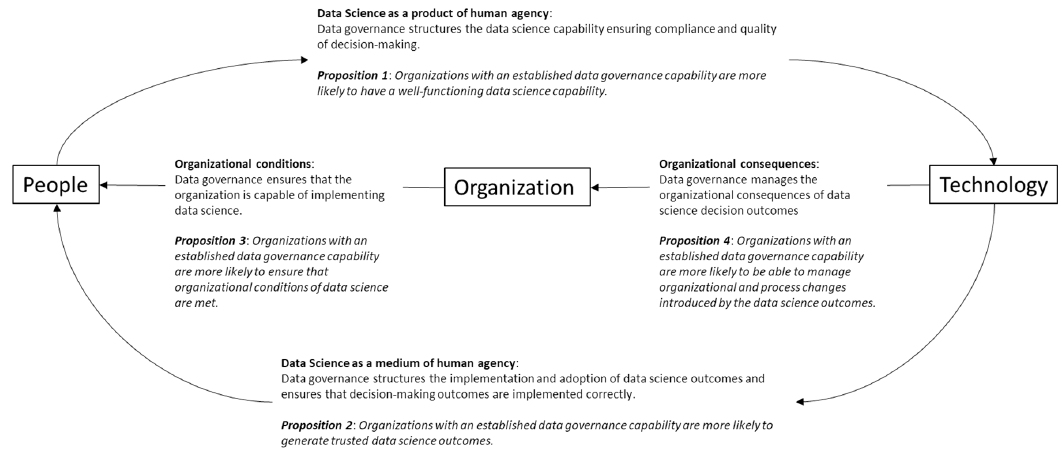
Figure 1. The relationship of the propositions with duality of technology. According to Orlikowski